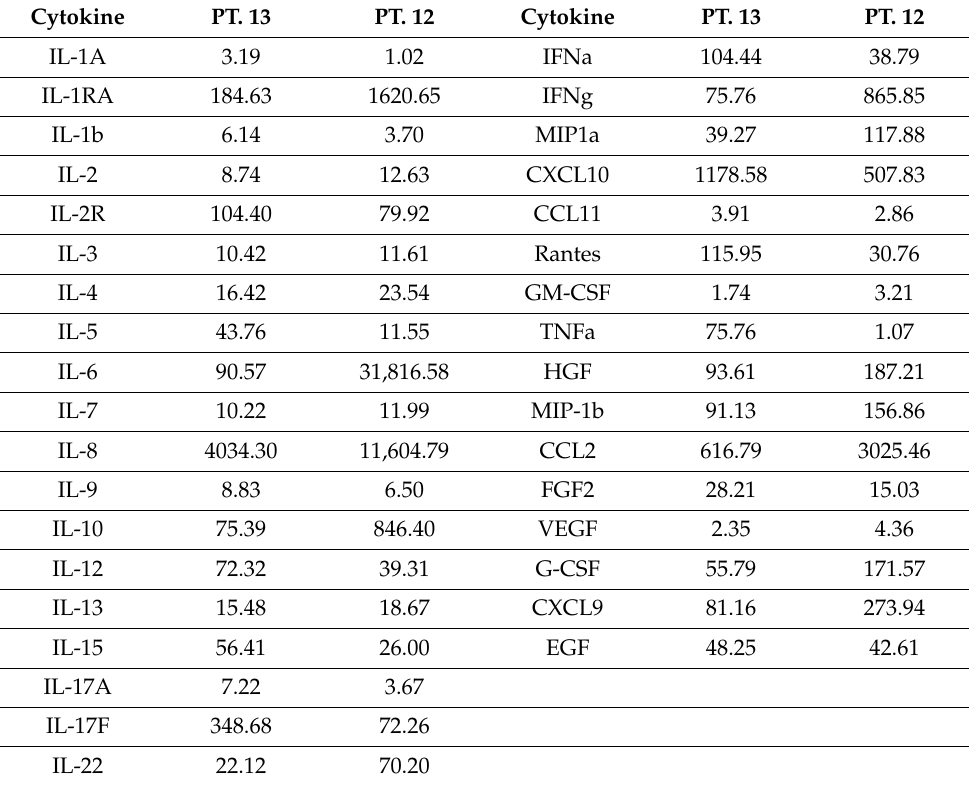
Table 2. Cytokine levels in the cerebrospinal